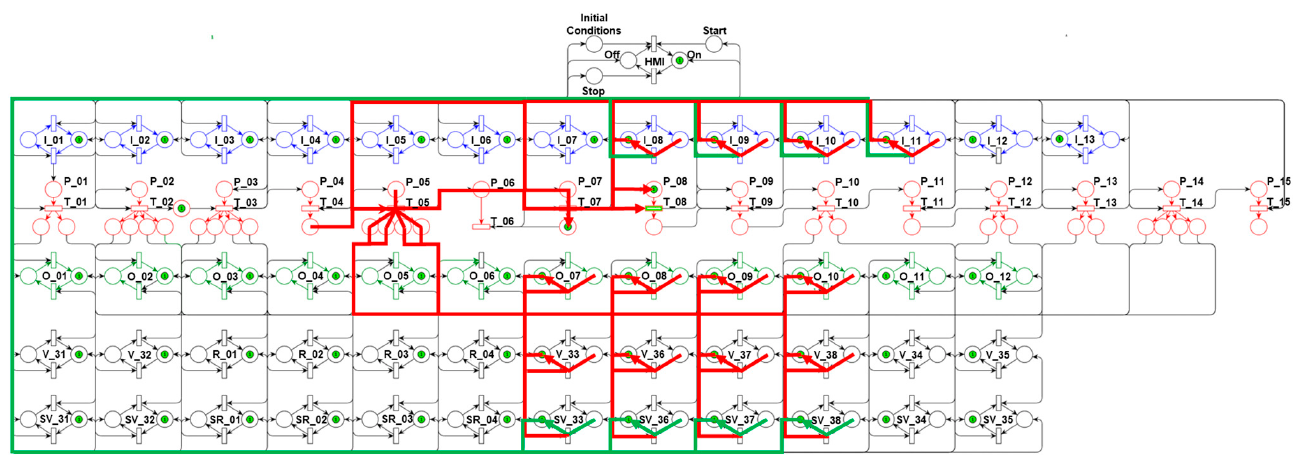
Figure 18. Algorithm’s sixth step—Close valves.